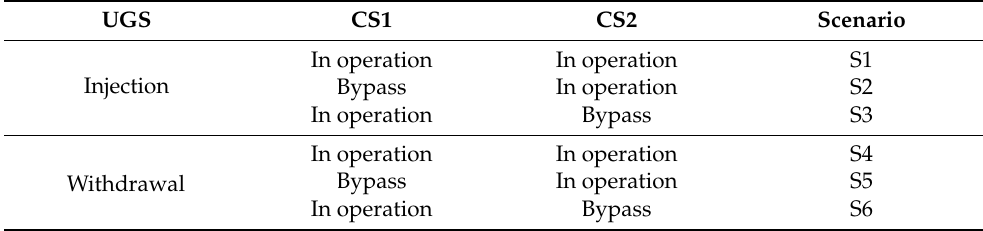
Table 2. Scenario definition in case study 1.